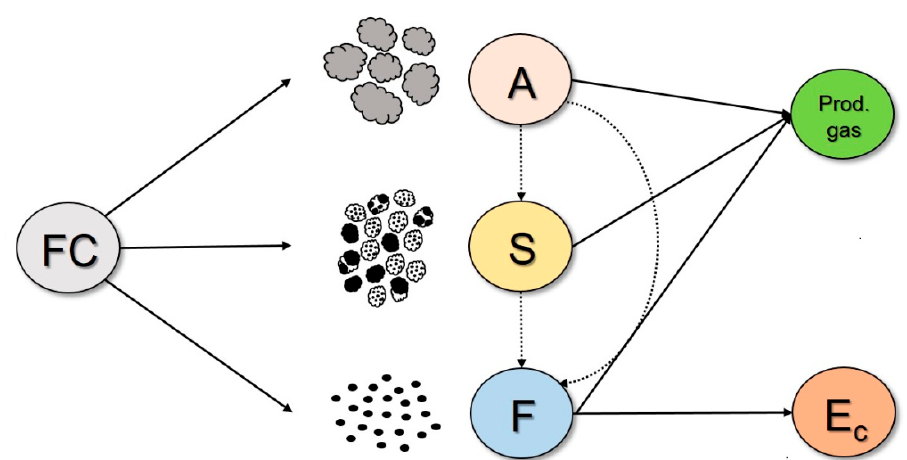
Figure 1. Carbon fractions present in the bed and their fate during the thermochemical conversion process: (FC) fixed carbon; (A) bed particle–carbon aggregates; (S) carbon-spotted bed particles; (F) flying carbon fines; (Ec) elutriated